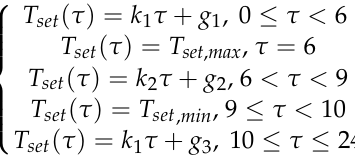
Figure 8. ( a ) Linear charging control curves of T set ( τ ) as an example of T set,max at 65 °C; ( b ) sharp charging control curves of T set ( τ ) as an example of T set,max at 65 °C; ( c ) slow charging control curves of T set ( τ ) as an example of T set,max at 65 °C.